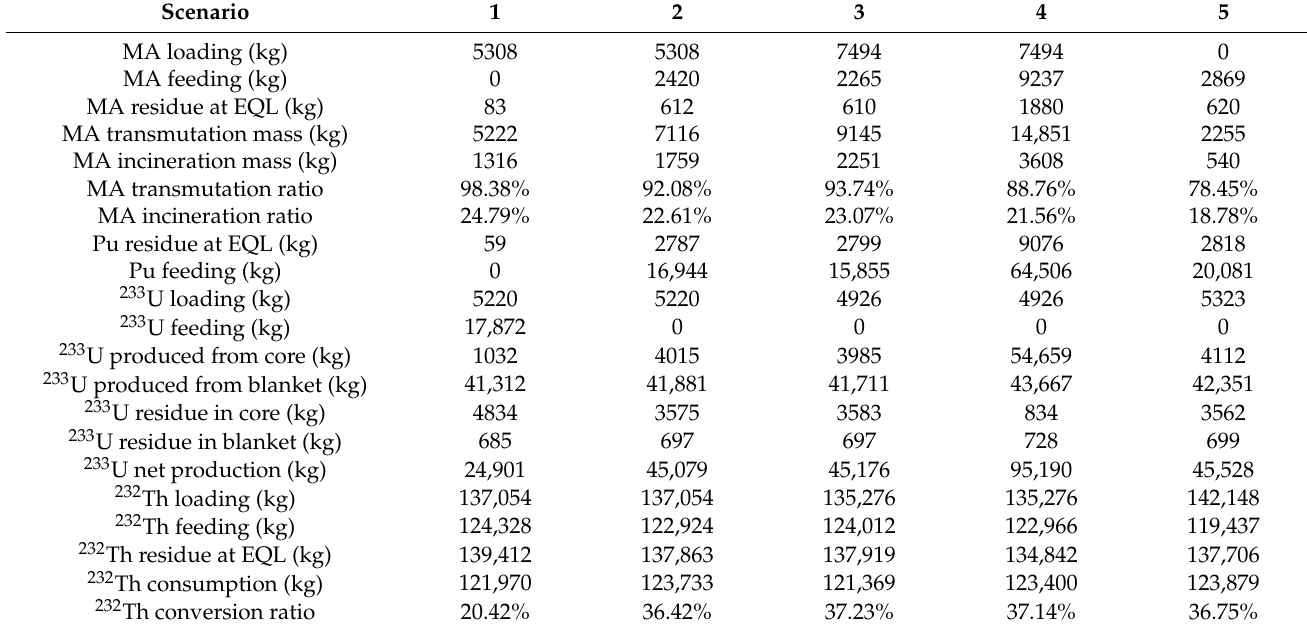
Table 4. Mass flow and MA incineration performances for different